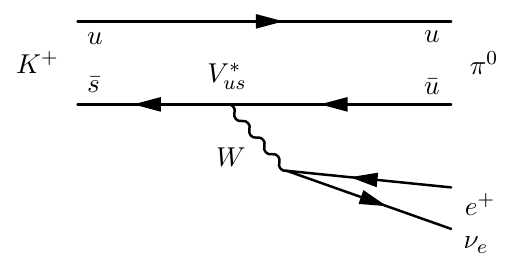
Figure 9 . Decay K + ! (cid:25) 0 e + (cid:23) e in the